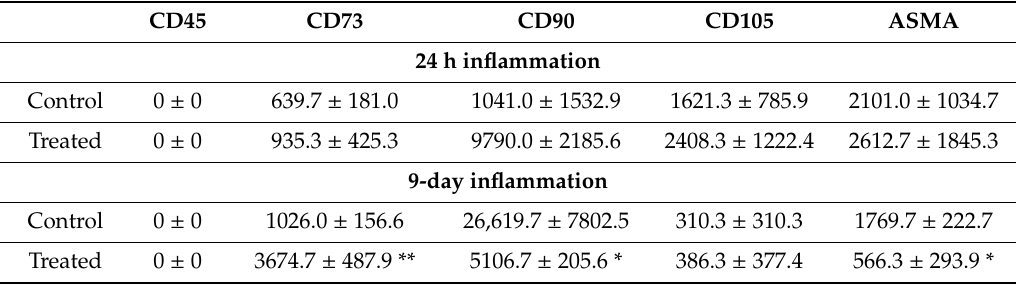
Table 4. E ff ect of inflammation on ADHLSC expression levels of mesenchymal markers: MFI (mean fluorescence intensity)